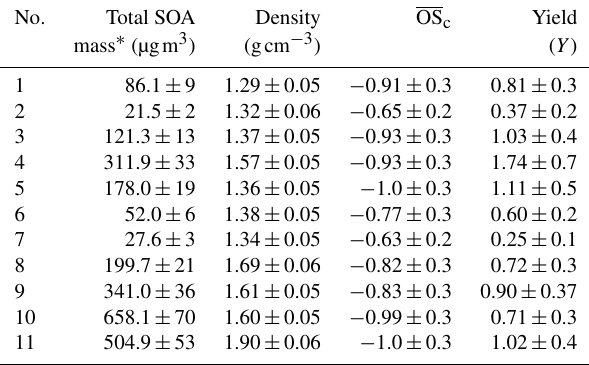
Table 6. Aerosol loadings, effective densities, oxidation states and yields for α -phellandrene ozonolysis